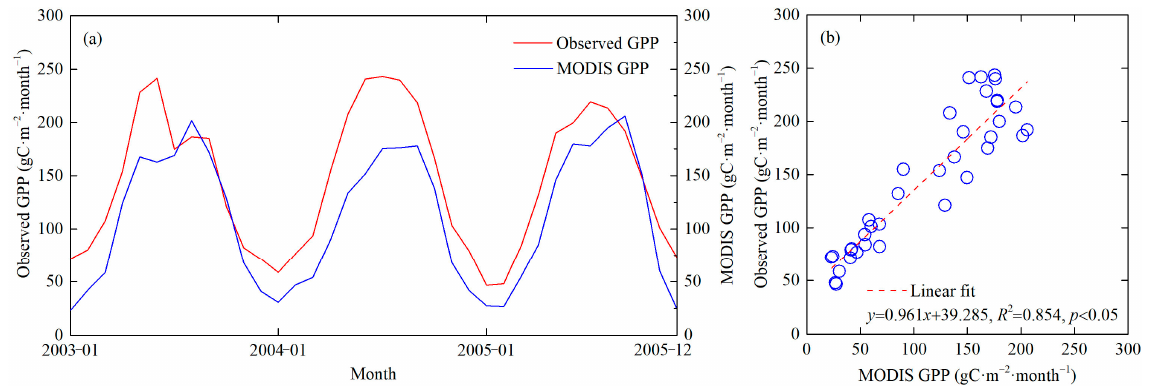
Figure 2. Comparison between the monthly observed GPP in Qianyanzhou flux tower and the monthly MODIS GPP ( a ) and their linear fitting ( b ) during 2003–2005. monthly MODIS GPP ( a ) and their linear fitting ( b ) during